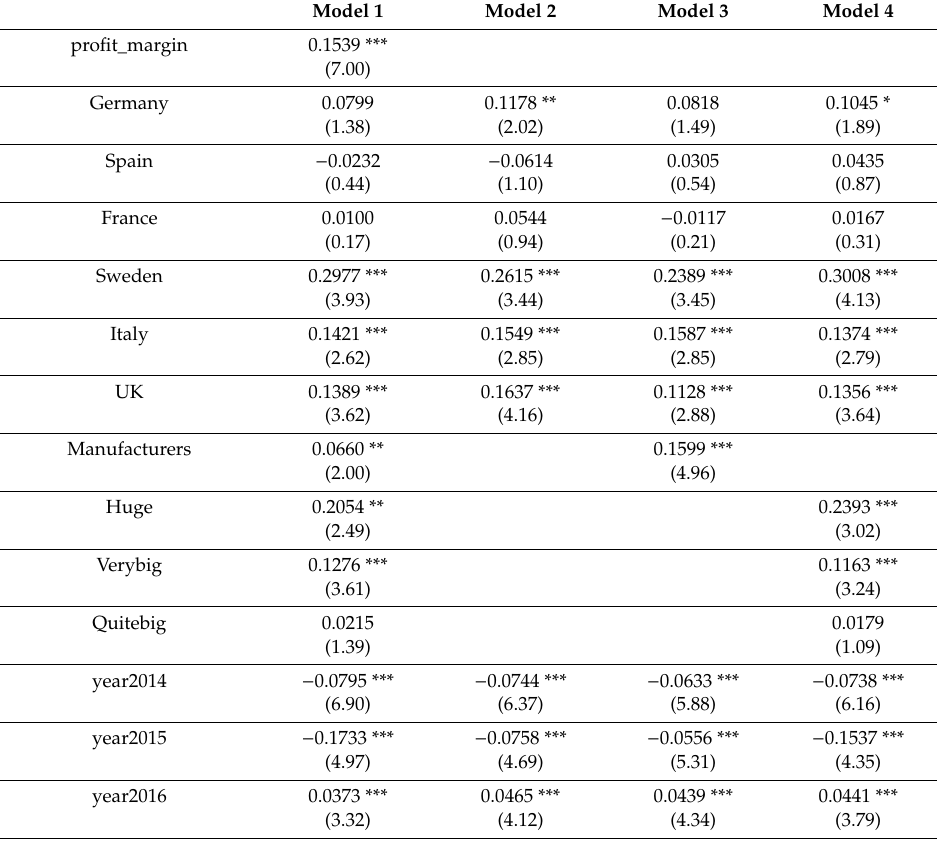
Table 4. Variables correlated with e ffi ciency, Tobit estimations. Dependent variable is e ffi